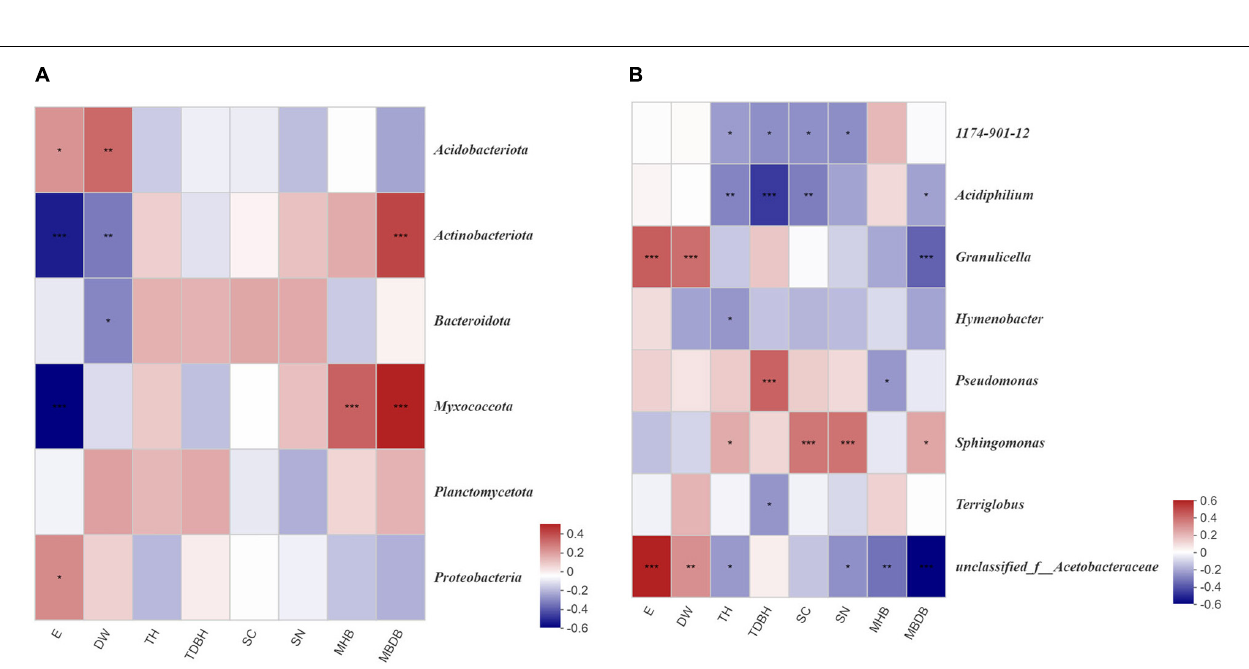
Frontiers in Microbiology |